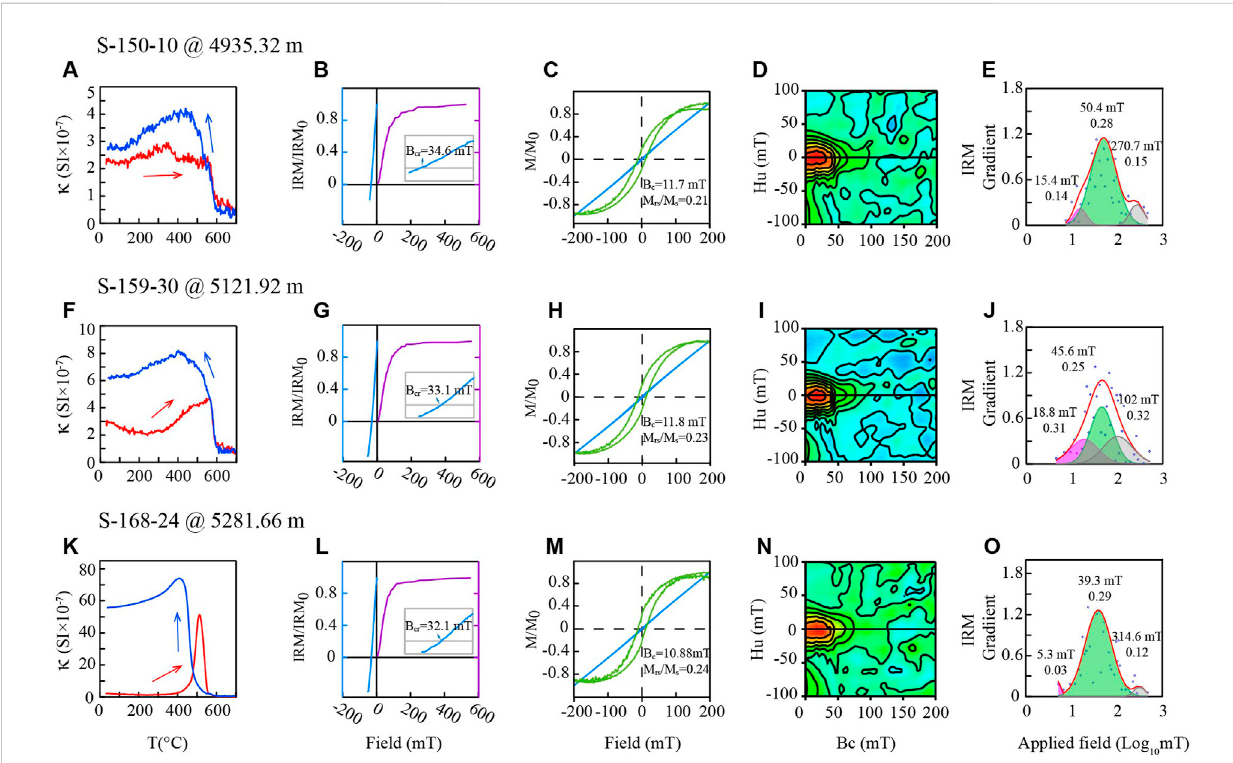
FIGURE 4 RockmagneticdiagnosisofthreeoftherepresentativesamplesselectedfromthelowerK 1 sh(depthforeachsamplecanbeseeninFIGURE.3(A)) (A, F, K) κ -T curves with red (blue) lines indicating heating (cooling) curves (B, G, L) Normalized IRM acquisition curves (purple lines) and reverse demagnetization curves (blue lines) with zooming plots showing B cr for each sample (C, H, M) Normalized hysteresis loops before (blue lines) and after (green lines) paramagnetic correction measured during room temperature. The maximum values of applied fi elds are set as 200 mT (D, I, N) FORC diagrams (smoothing factor=10) (E, J, O) IRM decomposition curves (Kruiver et al., 2001; Heslop et al., 2002): red lines are the fi tted results of the scattered blue diamonds which denote the gradients of IRM acquisition curves. Magenta, green, and grey shadings represent the maghemite (and/or coarse magnetite), fi ne magnetite, and hematite, respectively. The B 1/2 and DP values of each component have been